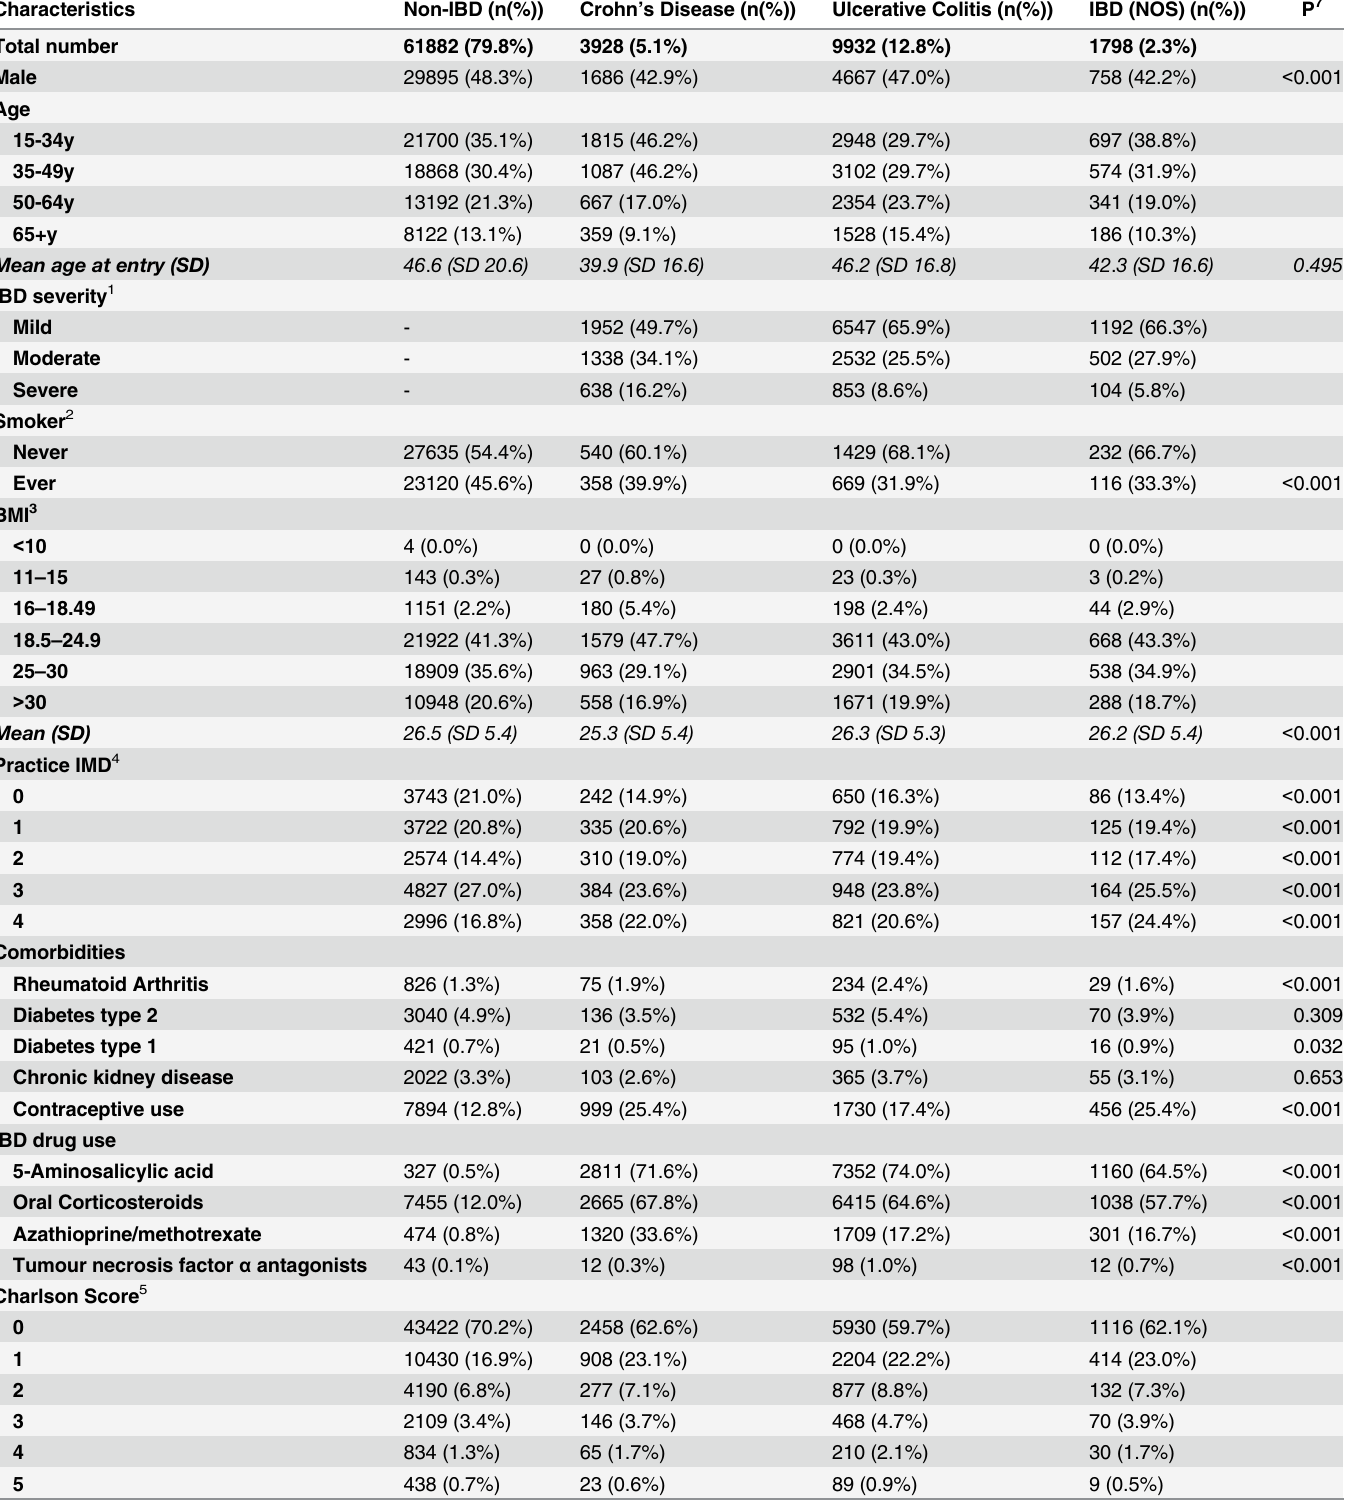
Table 3. COHORT B characteristics comparing non-IBD controls with IBD cases *